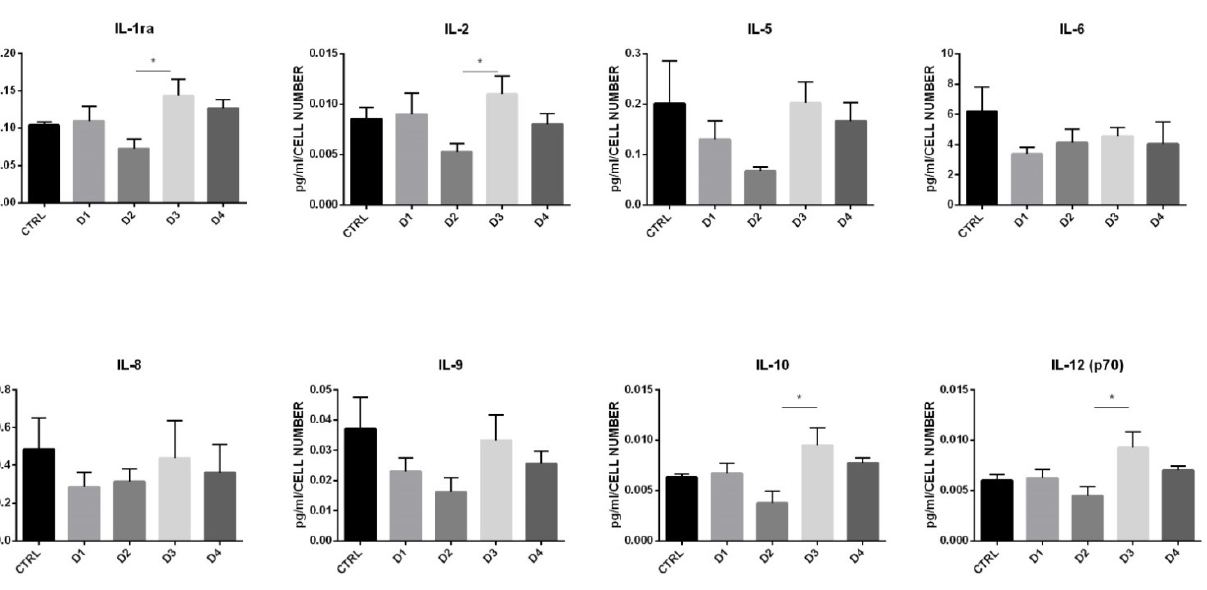
Figure 5. BFP-MSC-released cytokines, chemokines and growth factors. BFP-MSCs were plated in 12-well culture plates without disks (CTRL), on D1, D2, D3 or D4 for 72 h. Supernatants were collected and tested by using the Bio-Plex multiplex cytokine assay kit. * Denote statistical differences (* p < 0.05; ** p < 0.01).